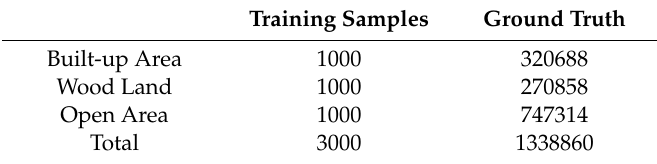
Table 3. Number of training samples and ground truth samples on the Oberpfa ff enhofen